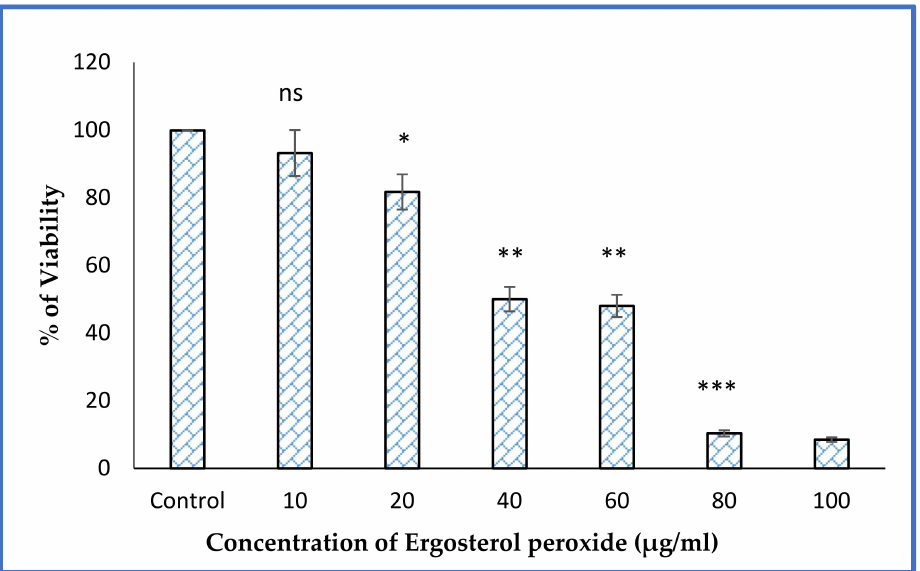
Figure 4. MTT assay of EP at different concentrations against MCF-7 cell line. Experiments were performed in triplicates. The results are expressed as mean ± SD. Significant difference between treated and control group were given as *( p < 0.05), ** ( p < 0.01), *** ( p < 0.001) and ns: